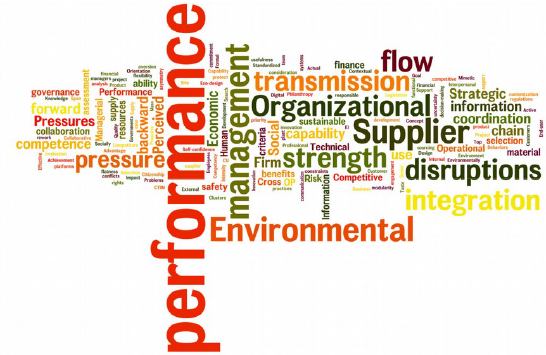
Figure 7. Cloud text for Latent Variables